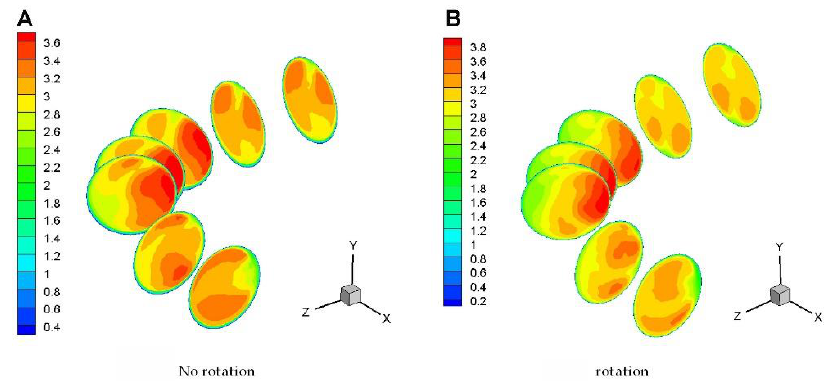
Figure 10. Velocity comparison of particle rotation at different cross-sections at the elbow.